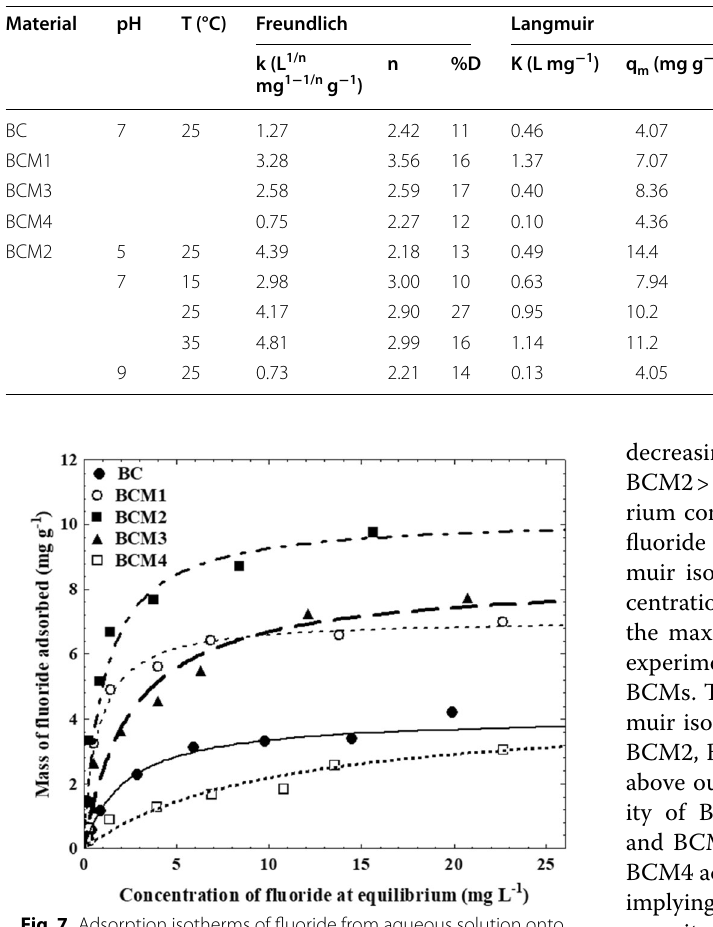
25 °C and pH 7. The lines = =